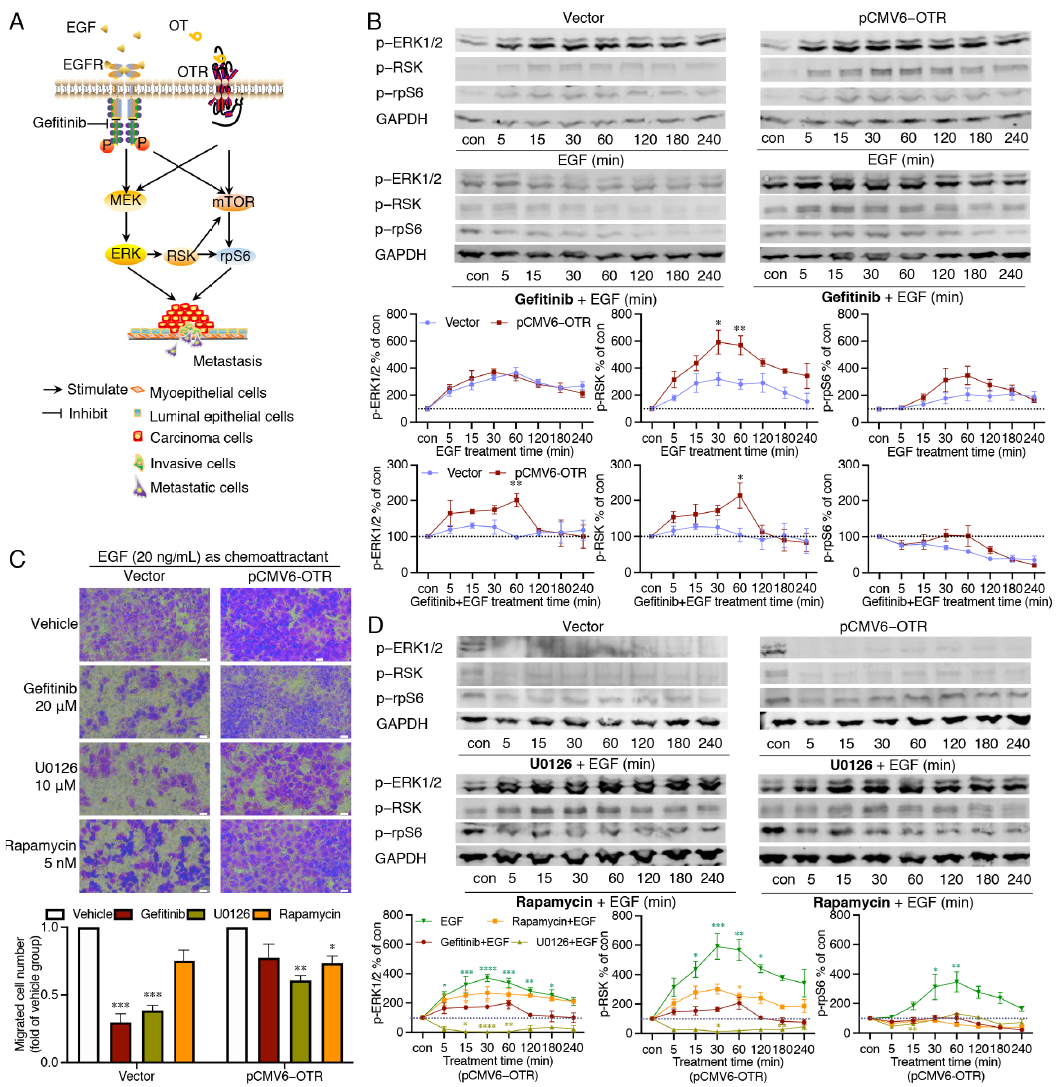
Figure 5. Effects of EGF on ERK1/2, RSK and rpS6 phosphorylation and migration ability in OTR- overexpressing cells. ( A ) EGFR and OTR independently induce ERK1/2 and mTOR signalling linked to cancer metastasis. ( B ) Representative Western blot images and quantification of phosphorylated ERK1/2, RSK, and rpS6 relative to GAPDH in EGF-treated cells with or without gefitinib (20 µ M) pre-treatment, the cells included control (vector) and OTR-overexpressing (pCMV6-OTR) MDA-MB- 231 groups. ( C ) Representative images (20 × objectives, scale bar (bottom right, white) = 21.18 µ m) and quantification of migrated MDA-MB-231cells (with or without OTR overexpression) attracted by EGF (20 ng/mL) and treated with inhibitors (n = 2 independent experiments with triplicates). ( D ) Representative Western blot images of phosphorylated ERK1/2, RSK, and rpS6 in control (vector group) or OTR-overexpressing (pCMV6-OTR group) MDA-MB-231 cells pre-treated with U0126 (10 µ M) or rapamycin (5 nM), with quantification of the phosphorylated ERK1/2, RSK, and rpS6 in control MDA-MB-231 cells. Con, control samples from cells without treatment, which reflected the base line of the protein activation status in ( B and D ). The quantitation of ERK1/2, RSK, and rpS6 phosphorylation were normalised relative to the level of GAPDH (n = 3 independent experiments). Vector group, MDA-MB-231 cells transfected with the vector plasmid, which were used as control cells without OTR overexpression; pCMV6-OTR group, MDA-MB-231 cells transfected with the pCMV6-OTR plasmid for OTR overexpression. Data were analysed using ANOVA analysis followed by Tukey’s multiple comparisons test. *, p < 0.05, **, p < 0.01, ***, p < 0.001, ****, p < 0.0001, vs. vehicle